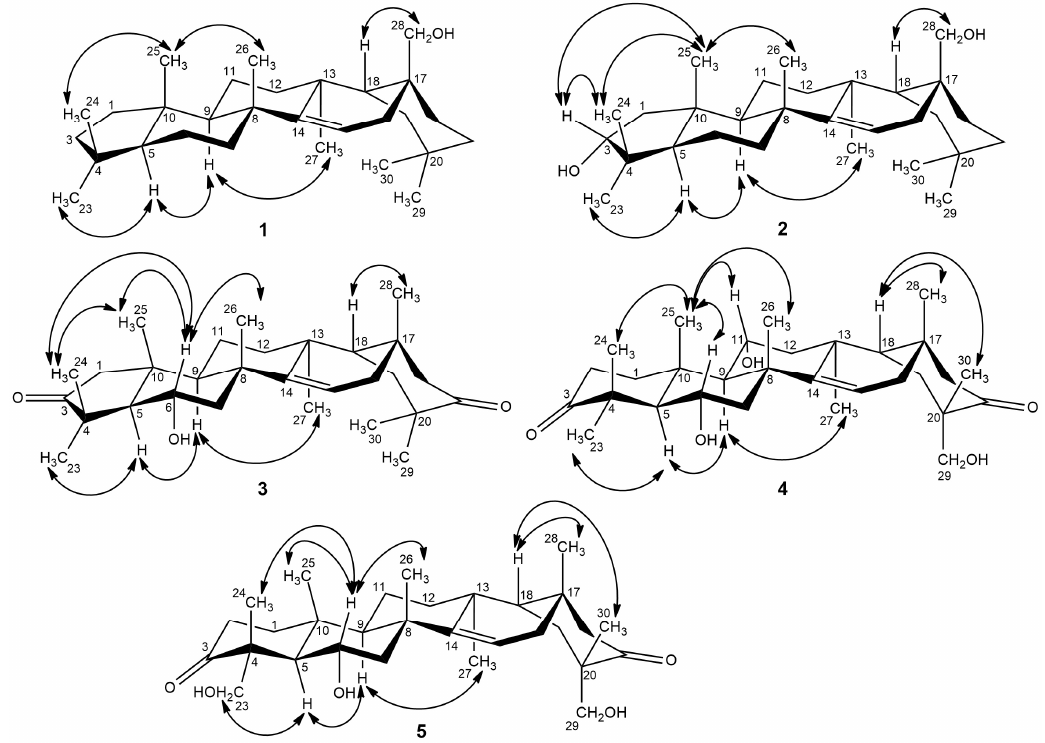
Figure 3. Key ROESY (H ↔ C) correlations of compounds 1 – 5